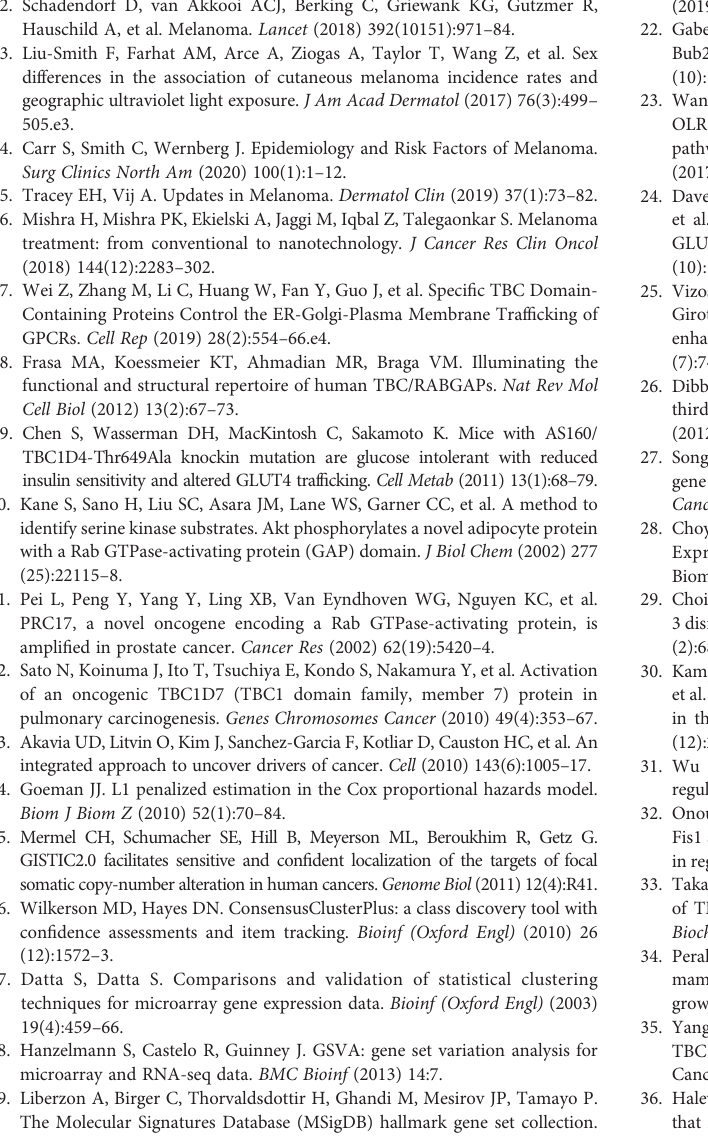
differences in DMS and DSS based on risk scores (High vs Low) in tumor tissues from the GEO dataset (65904). (C) Kaplan ± Meier survival analyses demonstrated the differences in PFI based on clusters (cluster 1 vs cluster 2) in tumor tissues. (D) Kaplan ± Meier survival analyses demonstrated the differences in PFI based on clusters (cluster 1 vs cluster 2) in metastasis tissues. (E) Kaplan ± Meier survival analyses demonstrated the differences in OS, PFI and DSS based on clusters (cluster 1 vs cluster 2) in primary tissues. SUPPLEMENTARY FIGURE 5 | GO and KEGG analysis. (A, B) Correlation analysis between the seven prognostic TBCs and the top 10 signi fi cant pathways from GO and KEGG